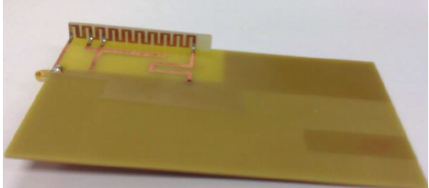
Figure 3: Photograph of the fabricated